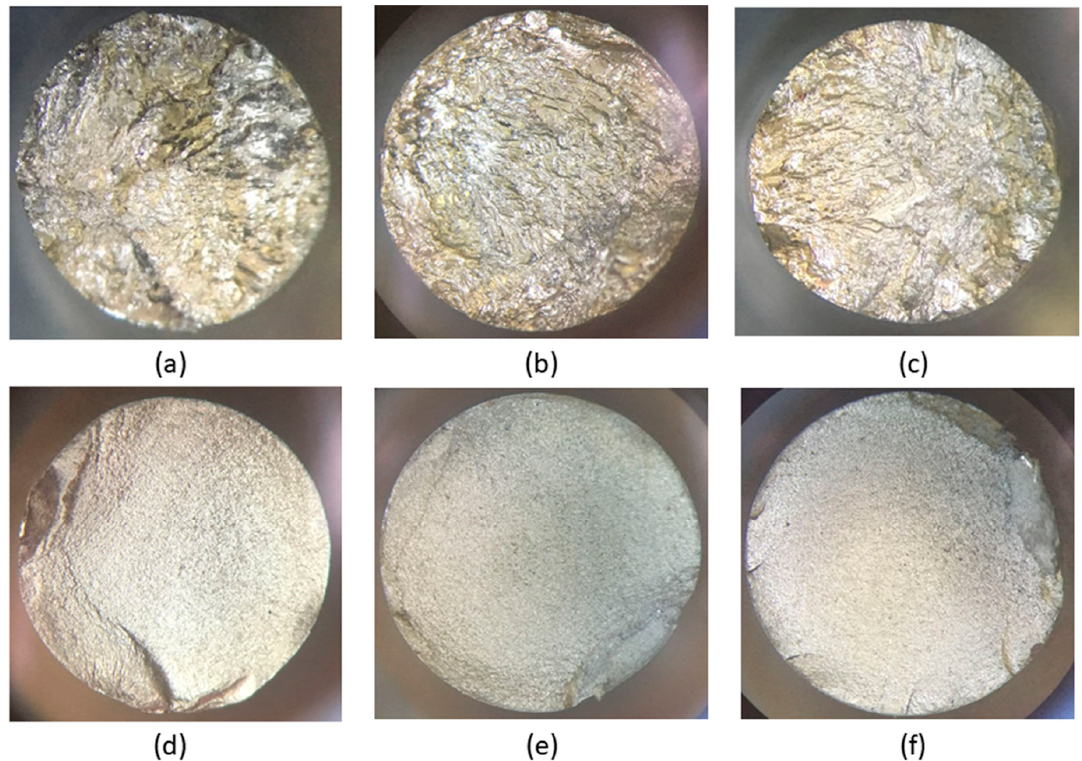
Figure 5. Fracture surfaces of specimens after the tensile test. These images were obtained using a stereoscopic microscope. Conditions: ( a ) non-nitrided specimen tested at 304 MPa and 123,700 cycles to failure, ( b ) non-nitrided specimen tested at 406 MPa and 68,700 cycles to failure, ( c ) non-nitrided specimen tested at 610 MPa and 6700 cycles to failure, ( d ) nitrided specimen tested at 304 MPa and 233,000 cycles to failure, ( e ) nitrided specimen tested at 406 MPa and 90,800 cycles to failure, ( f ) nitrided specimen tested at 610 MPa and 35,000 cycles to failure.